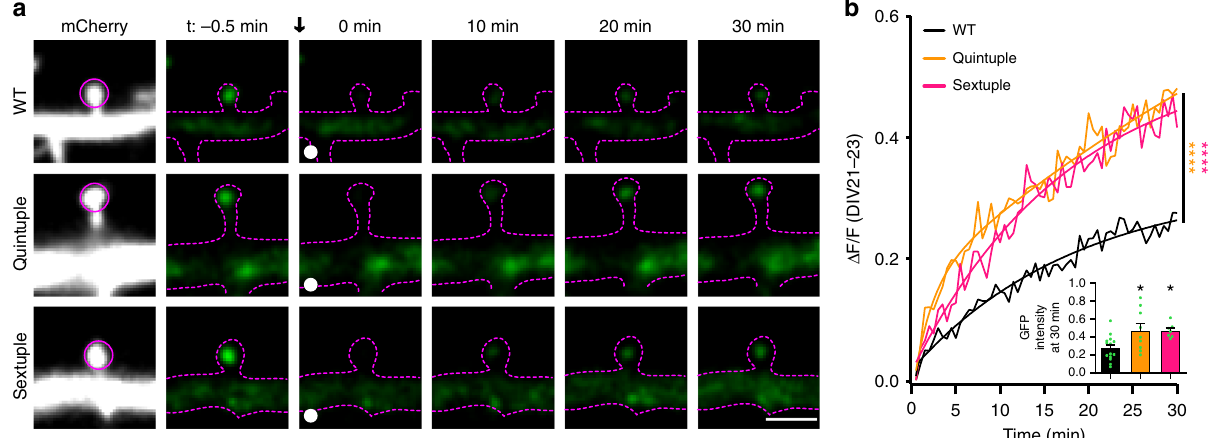
Fig. 4 Surface charge of the GluN1 NTD hinge region affects NMDAR mobility in mature neurons. a Representative FRAP images at different time points of DIV21 – 23 cortical neurons transfected with EGFP – GluN1 (WT, Quintuple, or Sextuple). Recovery of bleached spine puncta (magenta circle) was monitored for 30 min at 30-s intervals. Scale bar = 2 µ m. b Quanti fi cation of the recovery curve of different GluN1 mutants in DIV21 – 23 cortical neurons. Graphs represent mean intensity and show fi t (**** p < 0.0001, Kolmogorov – Smirnov (KS) nonparametric test). Inset: Quanti fi cation of the mobile fraction of EGFP – GluN1 puncta in dendritic spines at 30 min after photobleaching in EGFP – GluN1 mutant transfected cells compared to WT EGFP – GluN1 in DIV21 – 23 (* p < 0.05, ANOVA; green dots represent WT n = 14 puncta; Quintuple n = 11; Sextuple n = 10). Error bars show